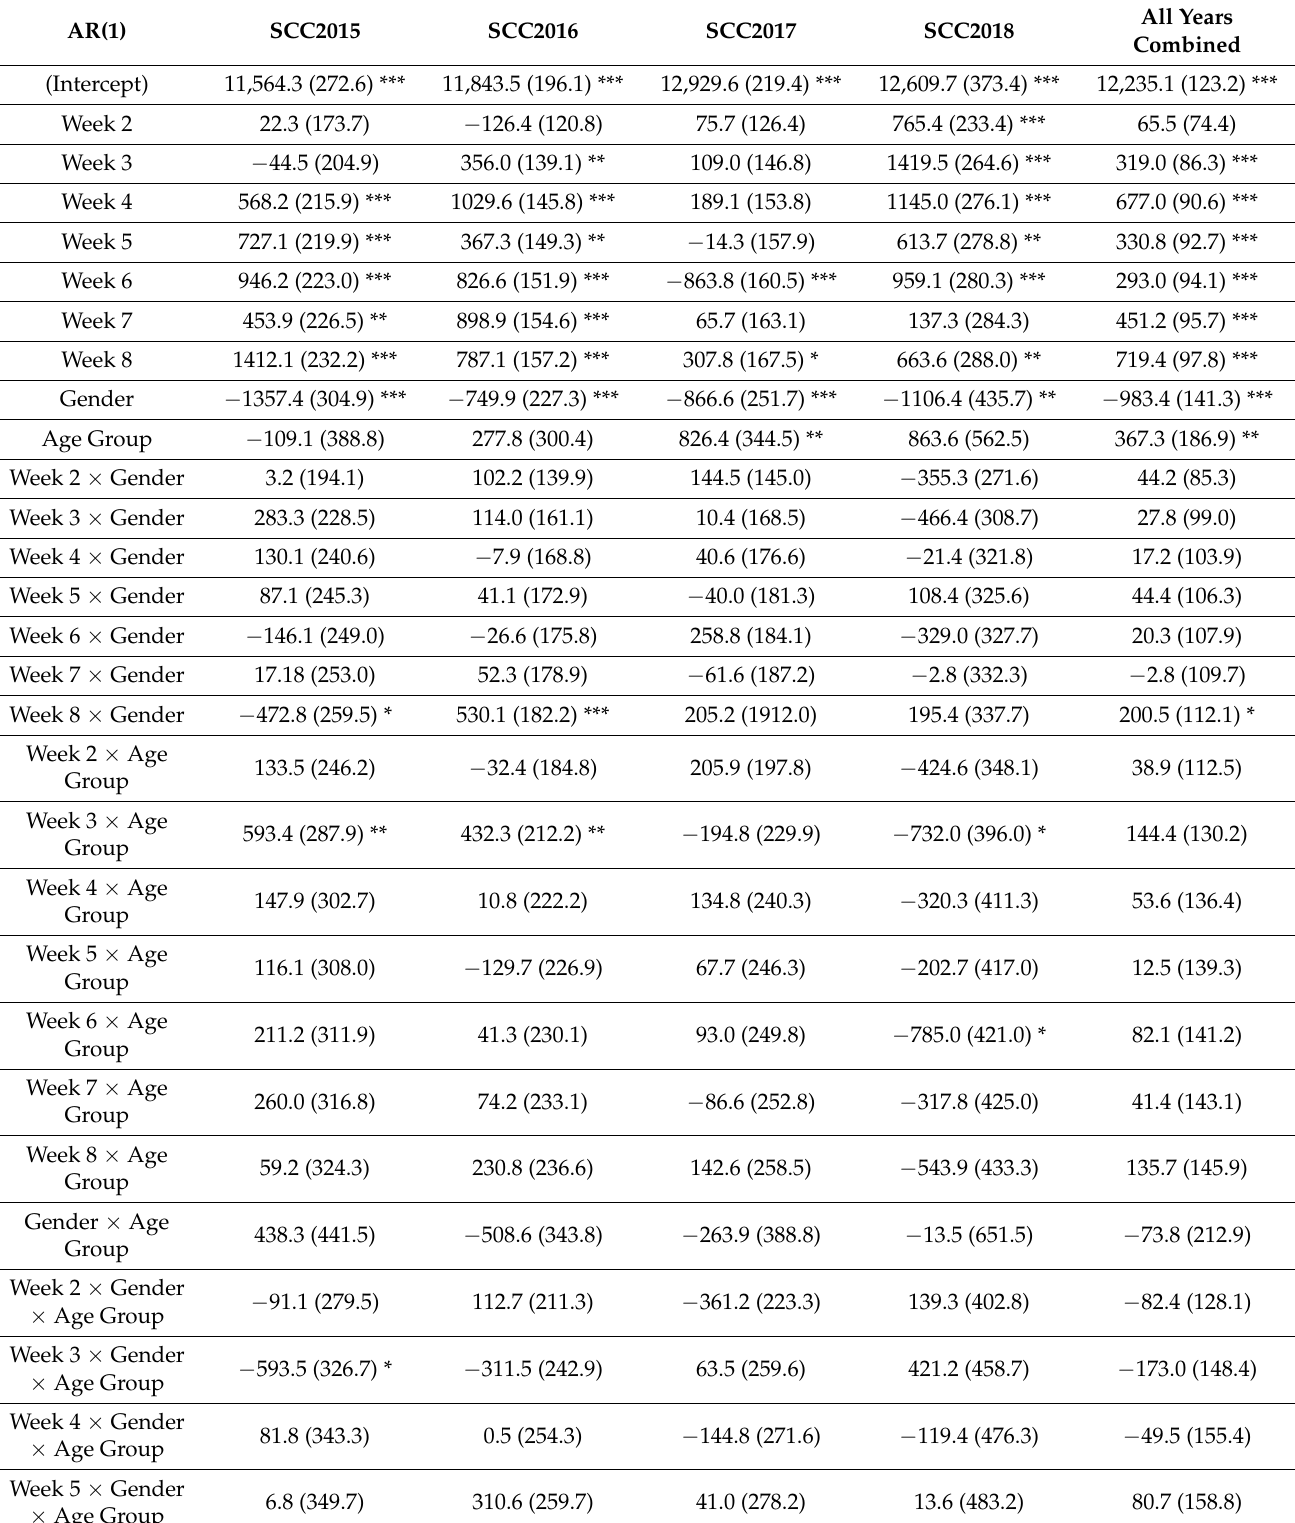
Table 3. Model 2: Gender and age effects on change in step count (mean and standard error) over time relative to